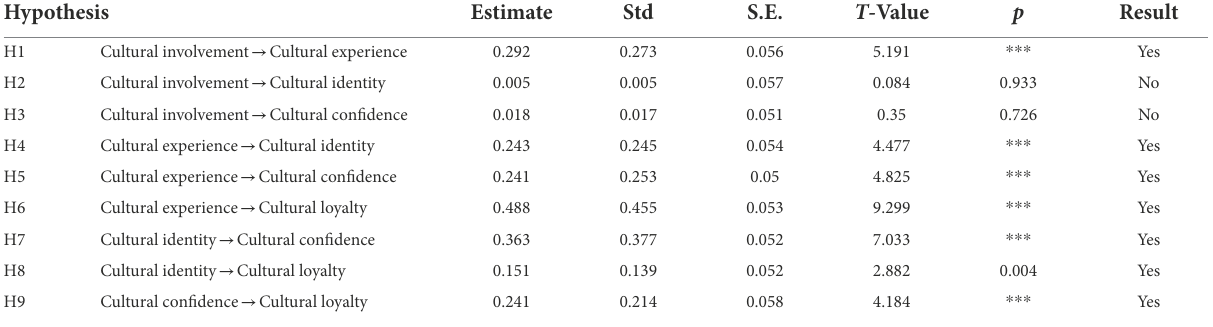
TABLE 4 Structure parameter estimates.